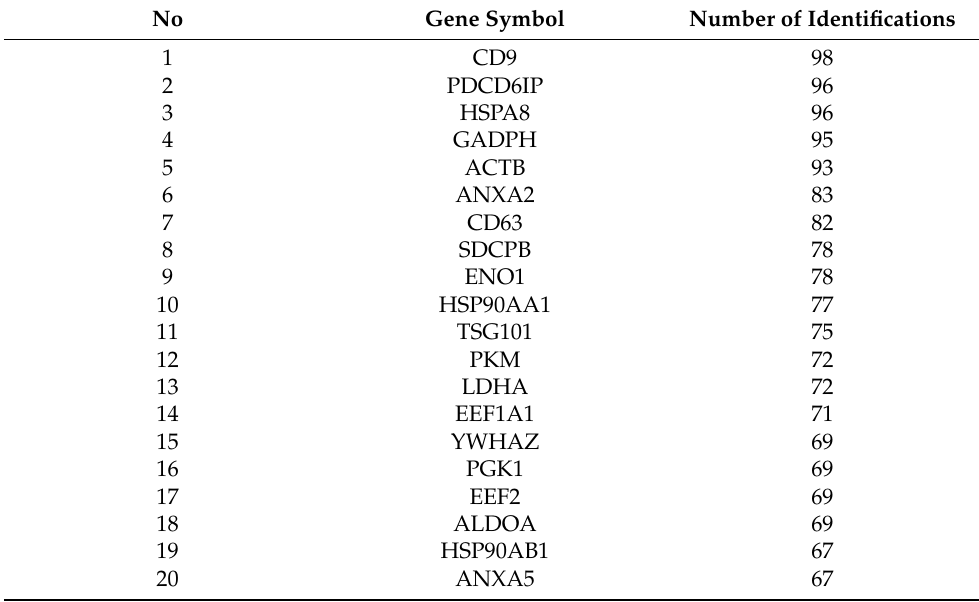
Table 1. Most specific exosomal proteins due to ExoCarta data (as of July